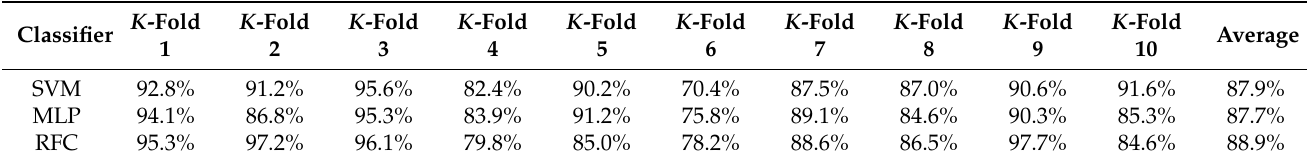
Table 1. Ten K -fold cross-validation results of each classifier.